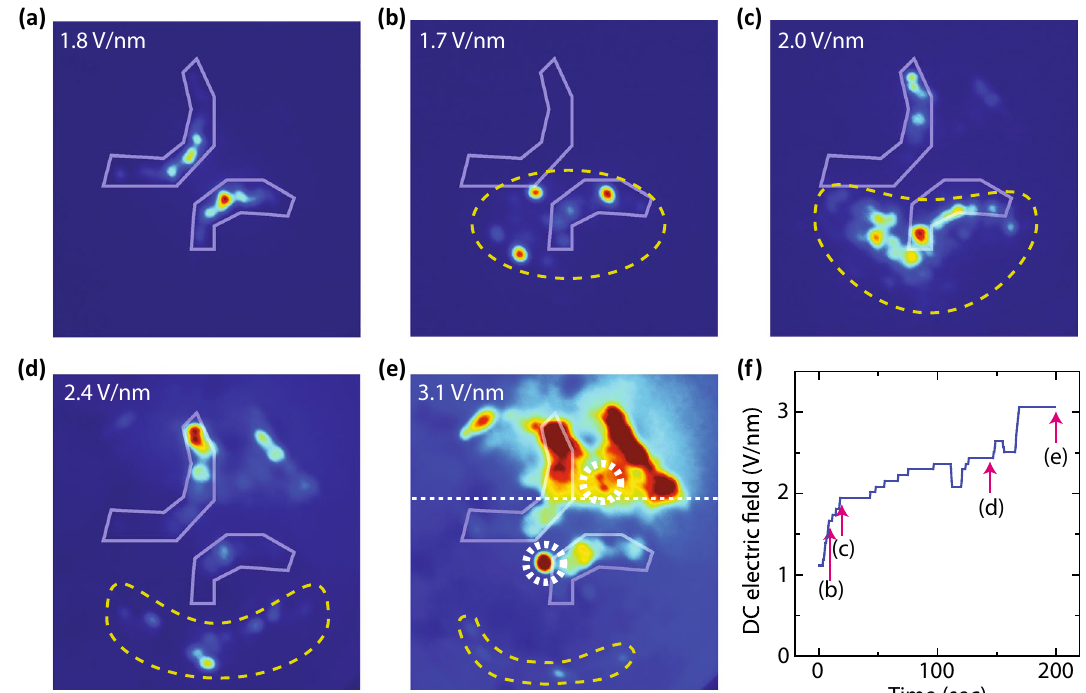
Figure 3. Evaporation of weakly-bound molecules by DC electric fields. ( a ) FEM image of clean tungsten carbide. ( b )–( e ) FEM images with increasing DC electric fields after the deposition of molecules. The electric fields are shown in the images. The electron signals from the weakly-bound molecules are surrounded by dashed lines. The emission areas of the tungsten carbide are highlighted by white lines. In ( e ), the peculiar molecule emission patterns are highlighted by dashed circles. ( f ) Applied DC electric fields and their corresponding timestamps in the